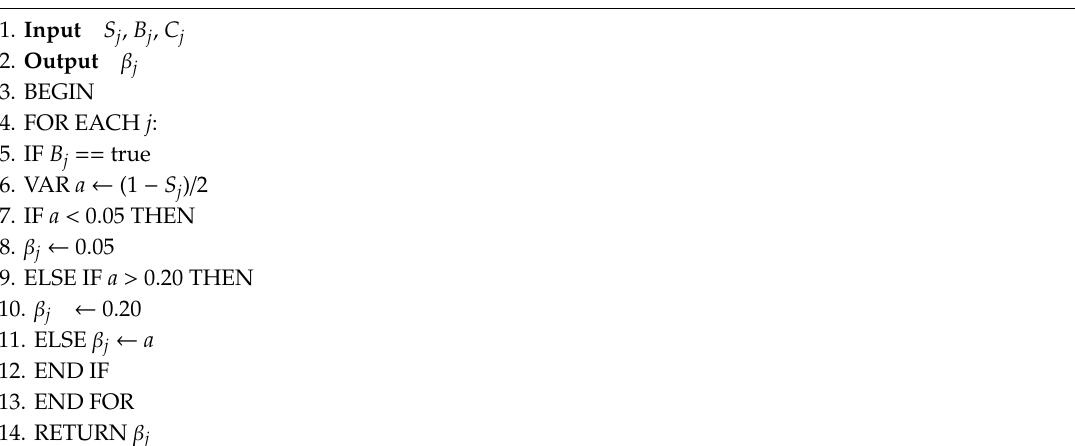
Algorithm 2: Feedback coe ffi cient